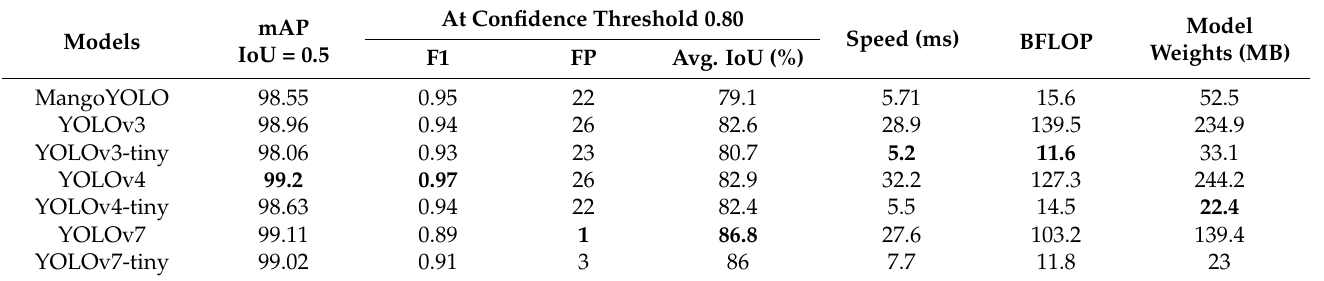
Table 4. Performance comparison of YOLO models for a mango fruit detection application. Training and test sets of [13] were used. Best result for a given criterion is shown in bold.